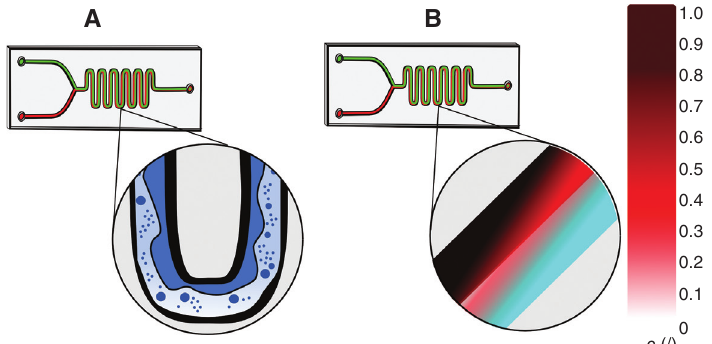
Figure 4 Multiphase flow visualisation (A) and local sensing in microstructured reactors